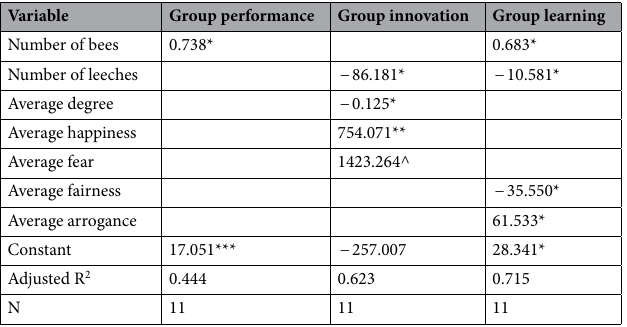
Table 6. Regression analysis—Healthcare Innovation dataset. ^p < 0.1; *p < 0.05; **p < 0.01; ***p < 0.001.